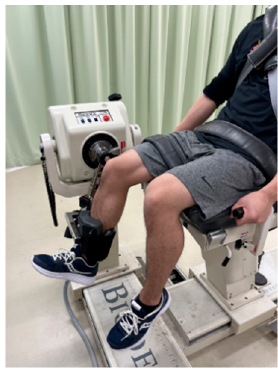
Figure 2. The set-up for knee extension muscle strength measurements. MVC-CON was measured at the angular velocity of 60 ◦ /s for a 70 ◦ ROM (20 ◦ –90 ◦ knee angle) for 5 continuous maximal voluntary concentric contractions for both directions